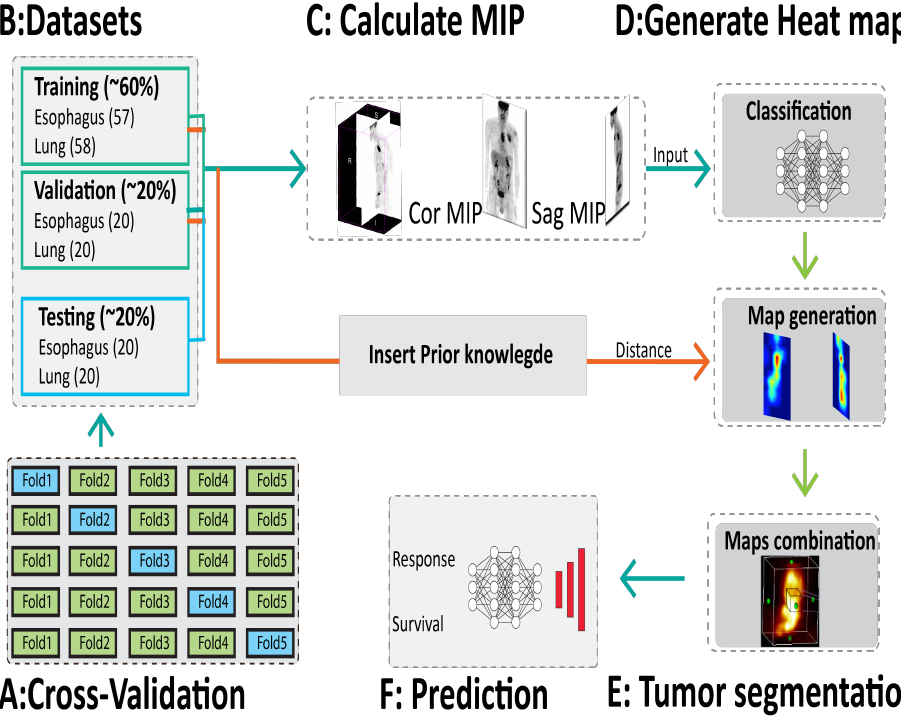
Figure 2. Study overview. ( A ) The dataset is divided five-fold for cross validation. ( B ) The data for each cross validation are divided into training, validation and testing. ( C ) Two MIPs in coronal and sagittal direction are calculated to be used as input for the neural network. ( D ) The neural network classifies the MIPs as lung or esophageal cancers and generates two heat maps corresponding to the two directions (coronal and sagittal). ( E ) The combination of the two heat maps allows for 3D tumor segmentation. ( F ) The segmented tumor is used as input to a second neural network for survival and response